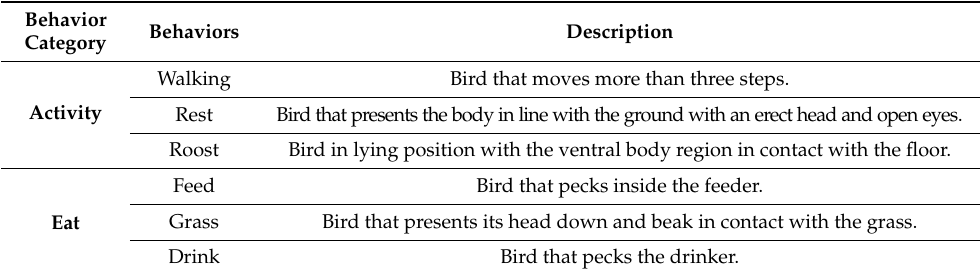
Table 1. Main behavioral patterns expressed by the chickens at 5 m from the